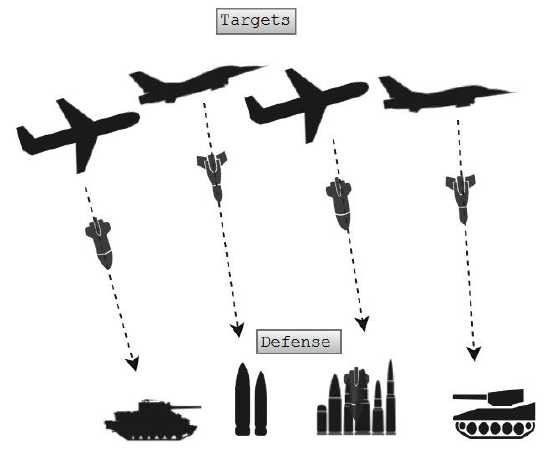
Figure 1. Illustration of the WTA